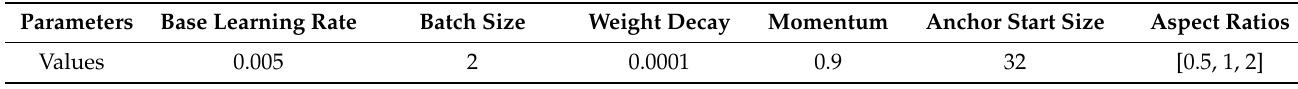
Table 5. Accuracy assessment of net detection results with Mask R-CNN.